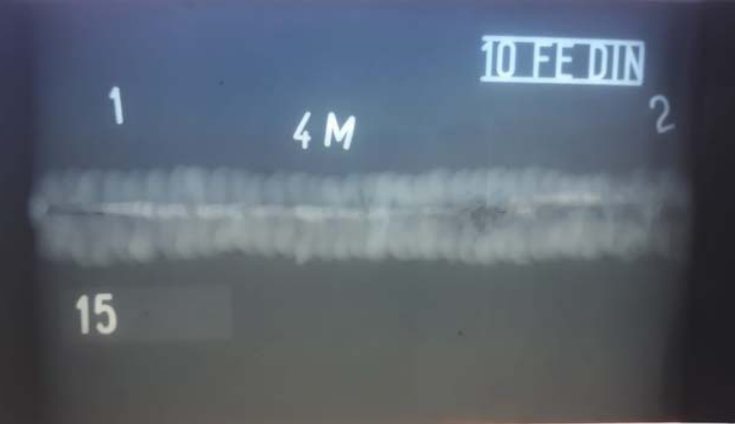
Figure 4. Real X ‐ ray radiography of a metallic weld with defects (lack of fusion and vermicular pores). Figure 4. Real X-ray radiography of a metallic weld with defects (lack of fusion and vermicular